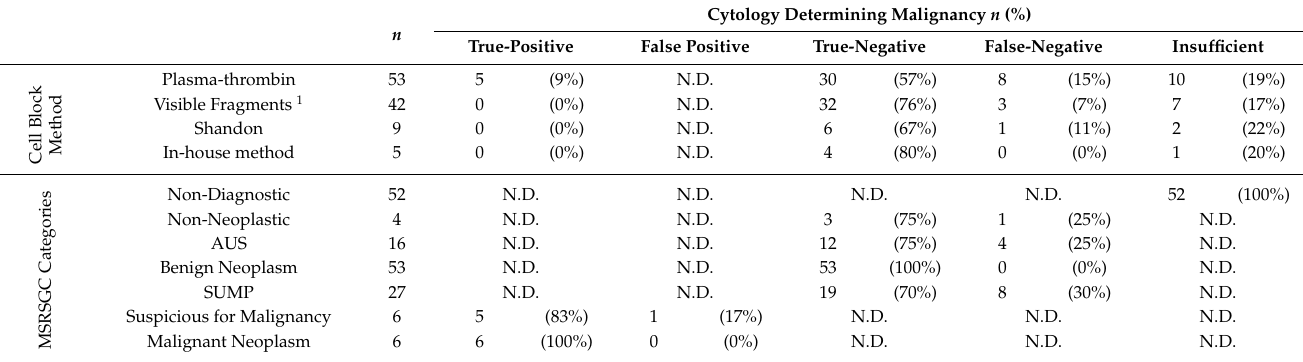
Table 4. Accuracy of Cytology Determining Malignancy.